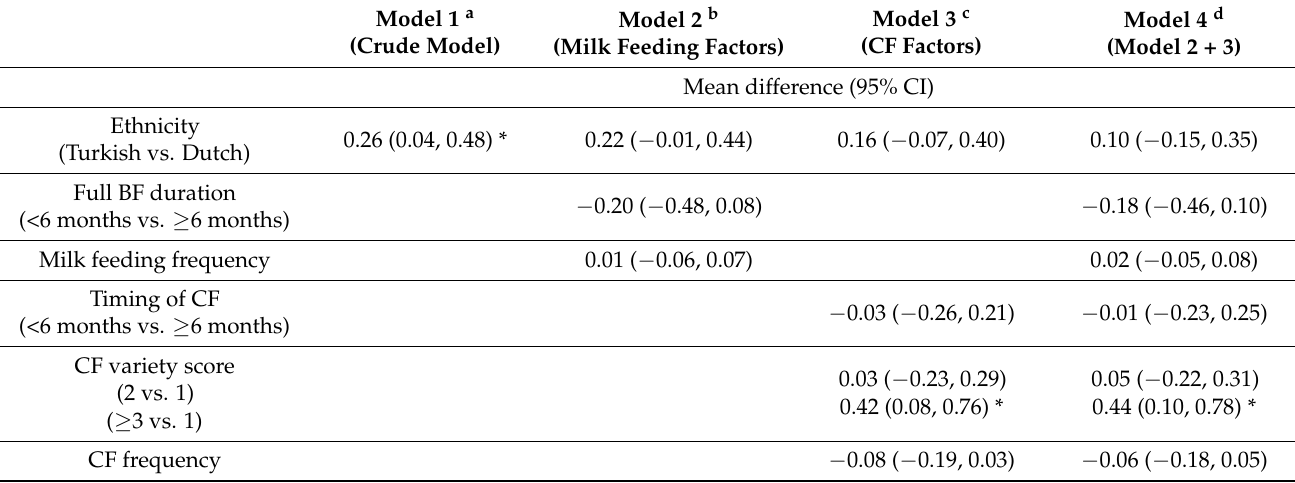
Table 3. Mean differences in estimated BMI-sds at age 3 years by ethnicity and feeding factors, derived from the LMR (models 1–4) and contribution of infant feeding